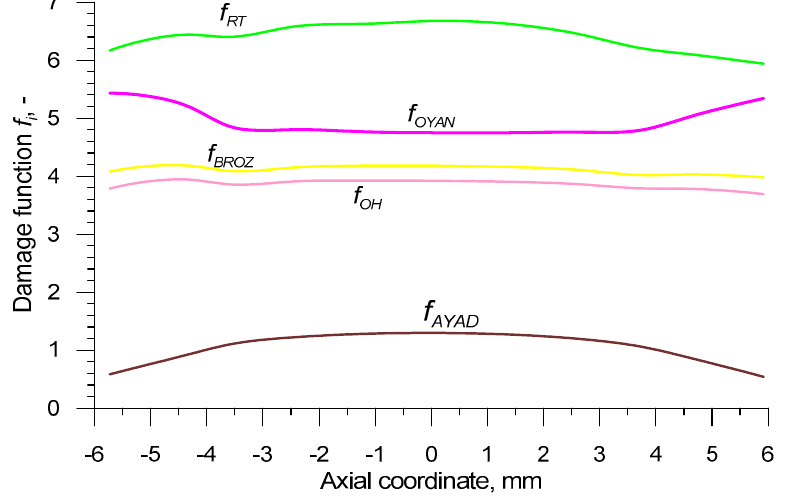
Figure 14. Distributions of the non-dimensional damage functions in the axis of the sample subjected to rotational compression in a channel at s = 700 mm and T = 1150 °C. Table 2. Critical damage values for C45 grade steel formed in 1150 °C, determined based on rotational compression in a channel.